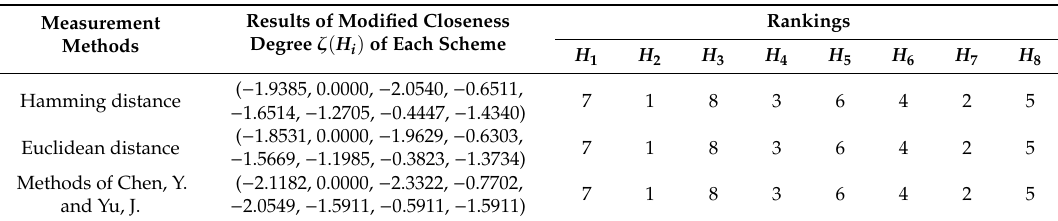
Table 7. Rankings obtained by three measurement